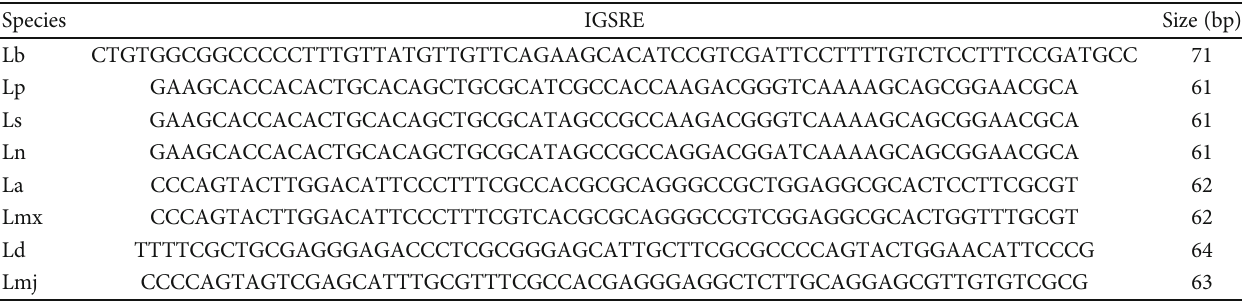
Table 6: Size of the IGSRE repetitive regions of di ff erent Leishmania spp. Species